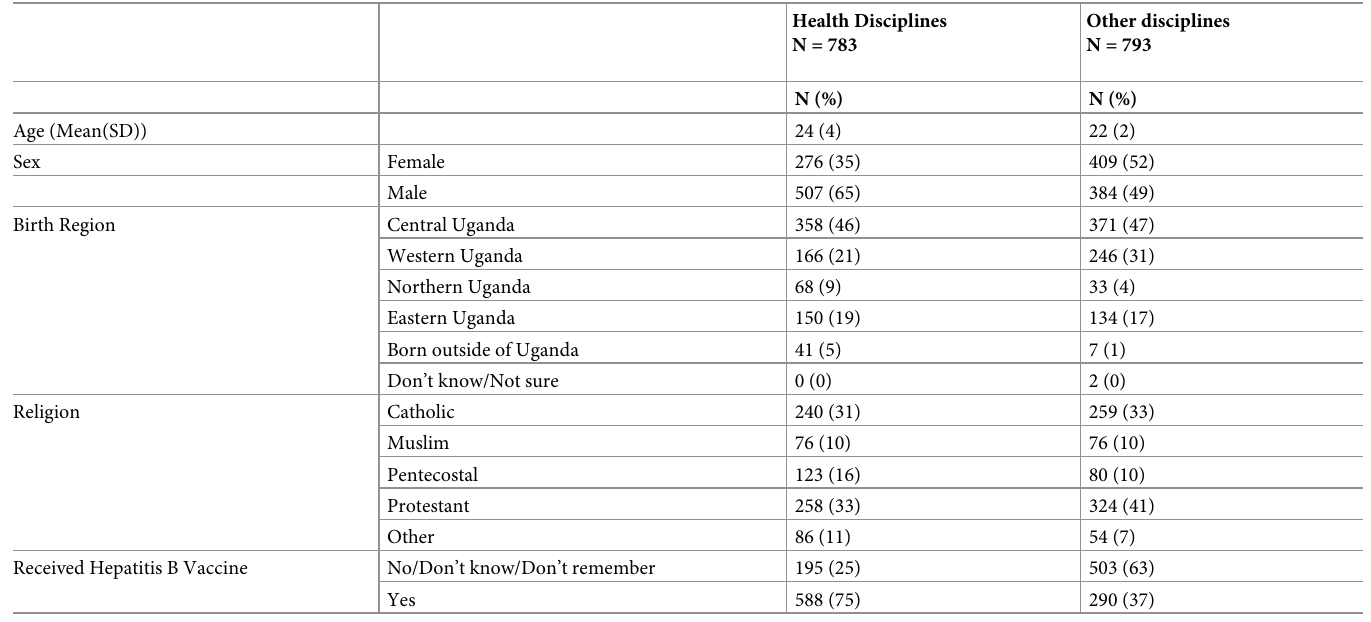
Table 2. Demographic characteristics of study participants who completed the DCE to assess their willingness to receive a vaccine.